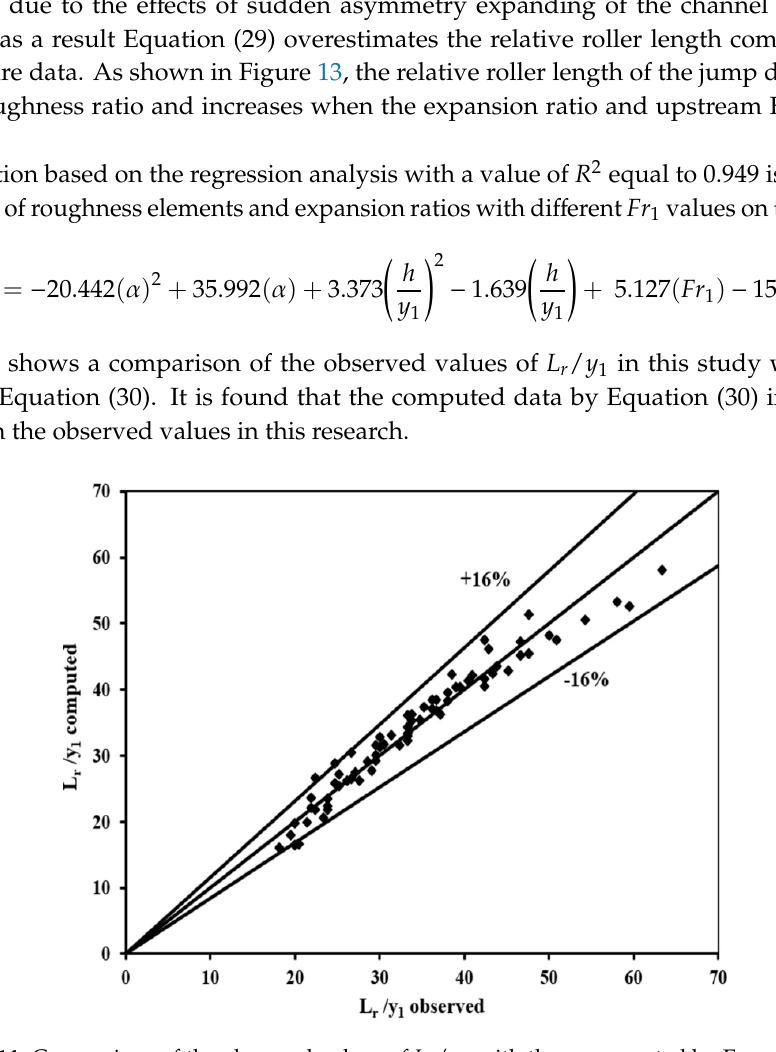
Figure 14. Comparison of the observed values of L r / y 1 with those computed by Equation (30).